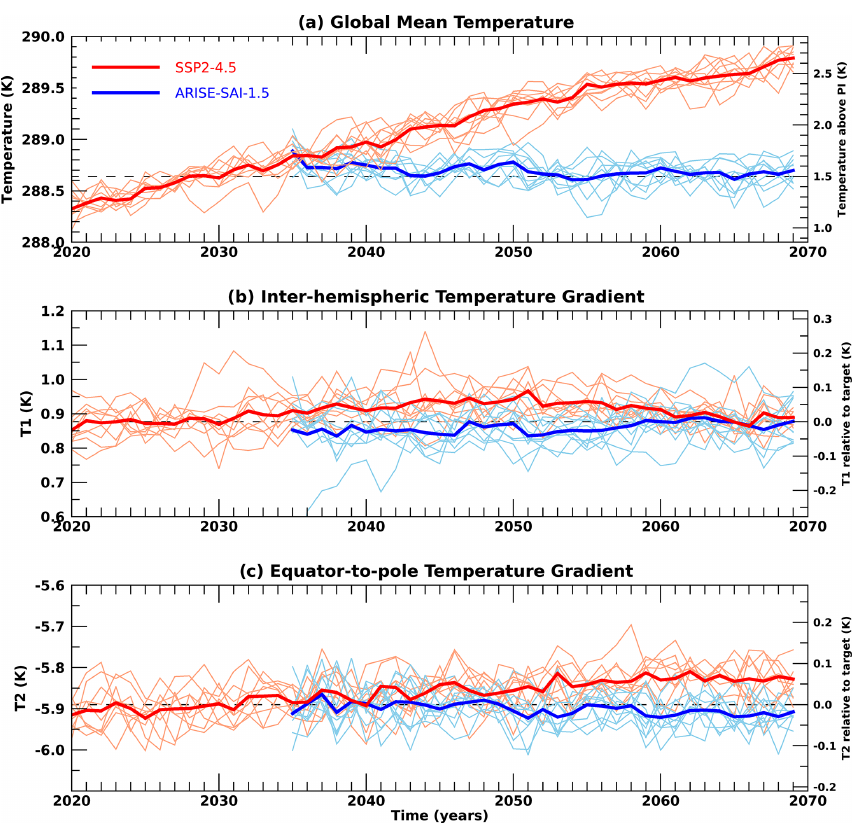
Figure 3. Global mean (a) surface temperature, (b) interhemispheric temperature gradient, T1, and (c) Equator-to-pole temperature gradient, T2, for SSP2–4.5 (red) and ARISE-SAI-1.5 (blue) simulations. Thin lines represent individual ensemble members, whereas the thick lines show the ensemble